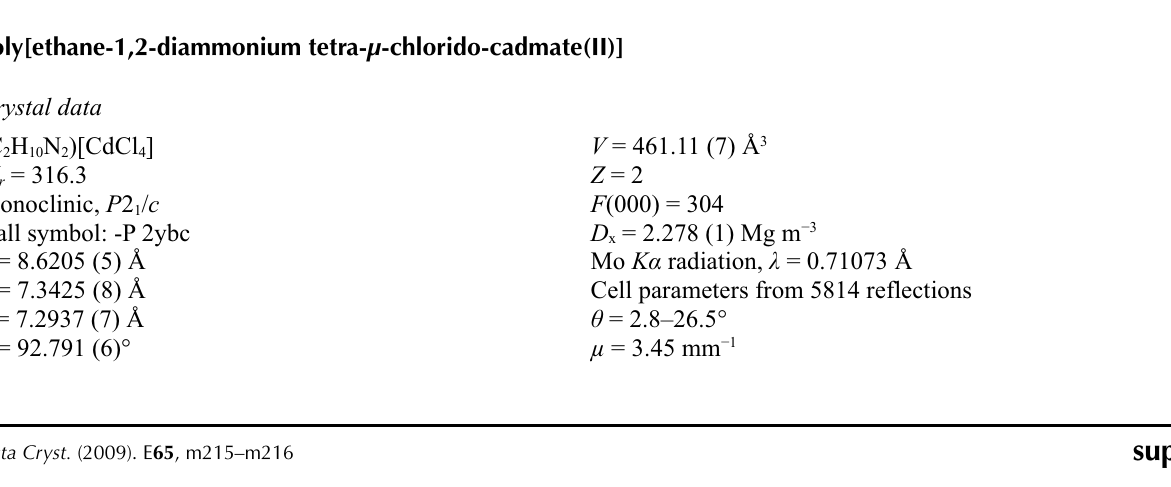
CH CH NH )[CdCl ] viewed along a . Color code: Pink balls (Cd), green balls (Cl), grey balls (C), blue 3 2 2 3 4